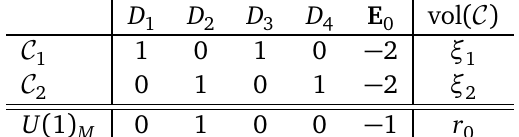
Figure 7: The resolved E the gauge-theory language, and the SU ( 2 ) gauge symmetry is restored at ξ